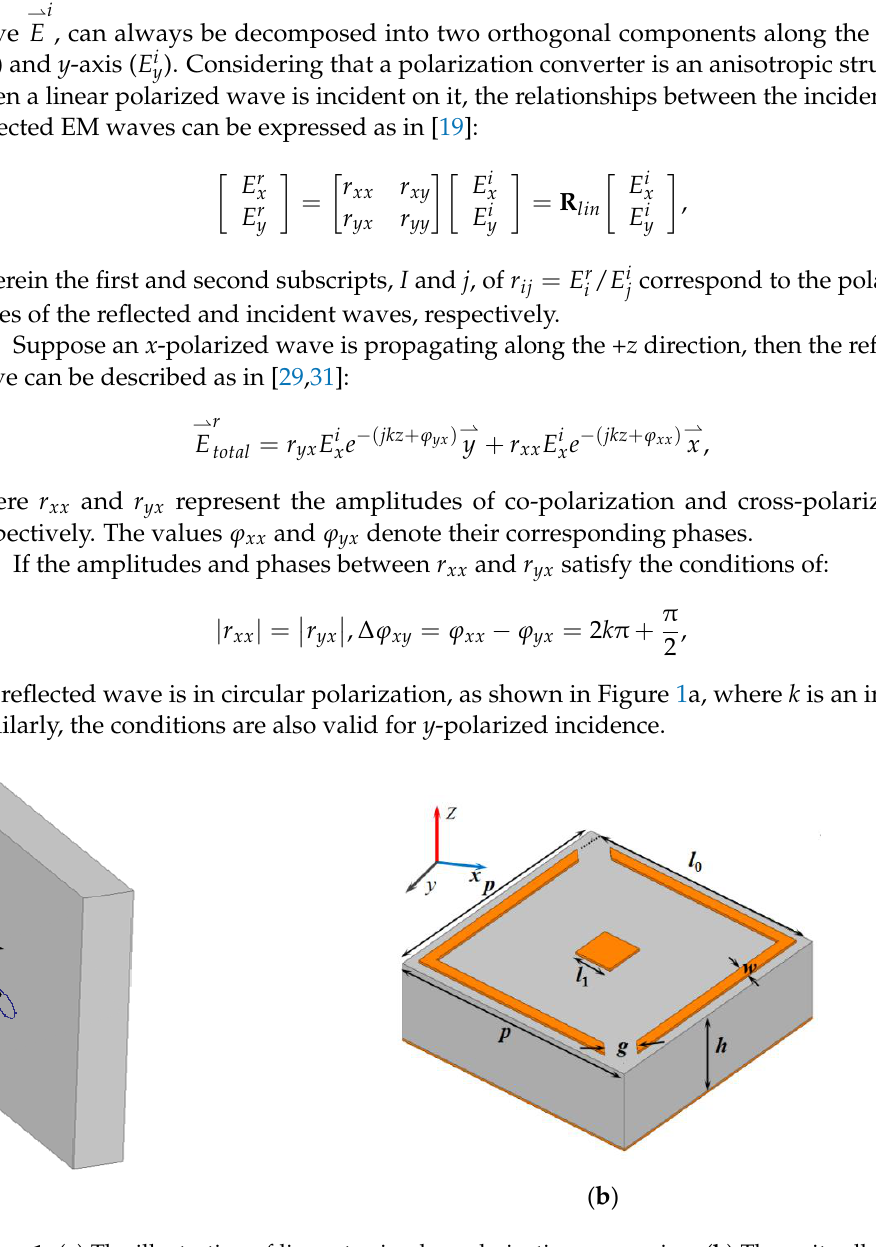
Figure 1. ( a ) The illustration of linear to circular polarization conversion; ( b ) The unit cell and its parameters.